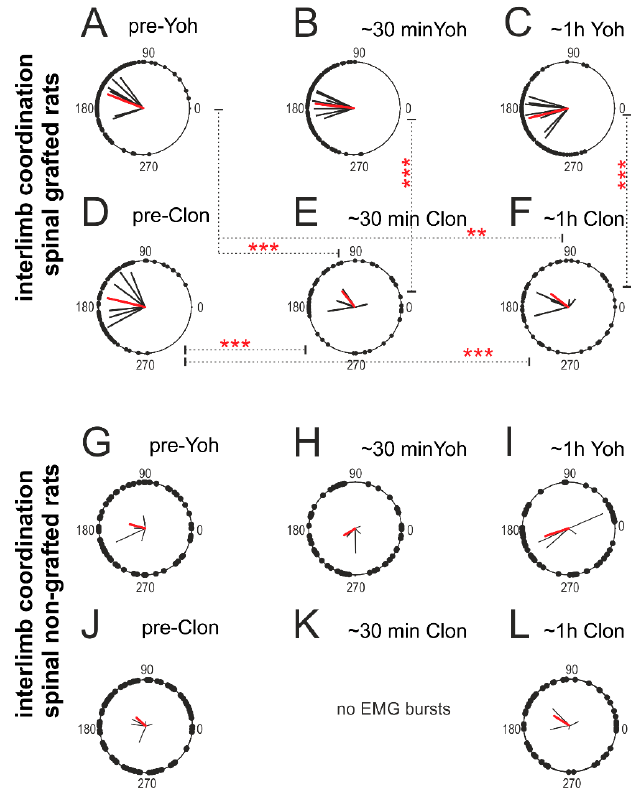
Figure 9. Interlimb coordination in locomotor performance (established between left vs. right TA muscles) in spinal grafted rats ( n = 6) after yohimbine ( A – C ) and clonidine ( D – F ) application. Interlimb coordination in locomotor performance (established between left vs. right TA muscles) in spinal non-grafted rats ( n = 5) after yohimbine ( G – I ) and clonidine ( J – L ) application. Black vectors are established for each pair of TA muscles in individual rats. Red vectors are the mean for the group of animals. Single dots in the polar plots illustrate the phase shift between analyzed onsets of EMG burst of left vs. right TA in individual step in all the analyzed animals. RM ANOVA with Tukey’s multiple comparisons ** p < 0.01; *** p < 0.001. Abbreviations: Clon—clonidine; Yoh—yohimbine; ~30 min—< 30 min after drug application; ~1 h—one hour after drug application.